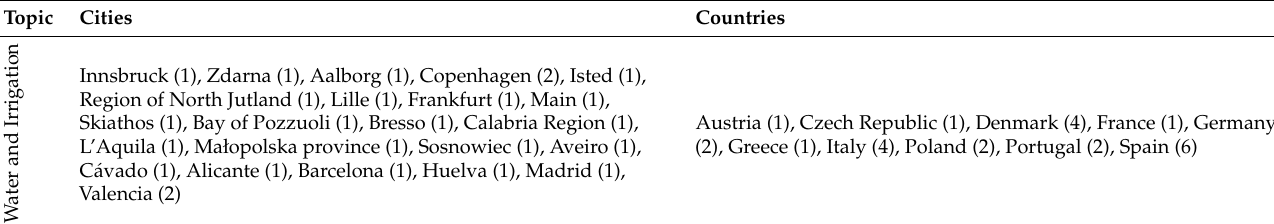
Table A2. Smart City initiatives organized by city and